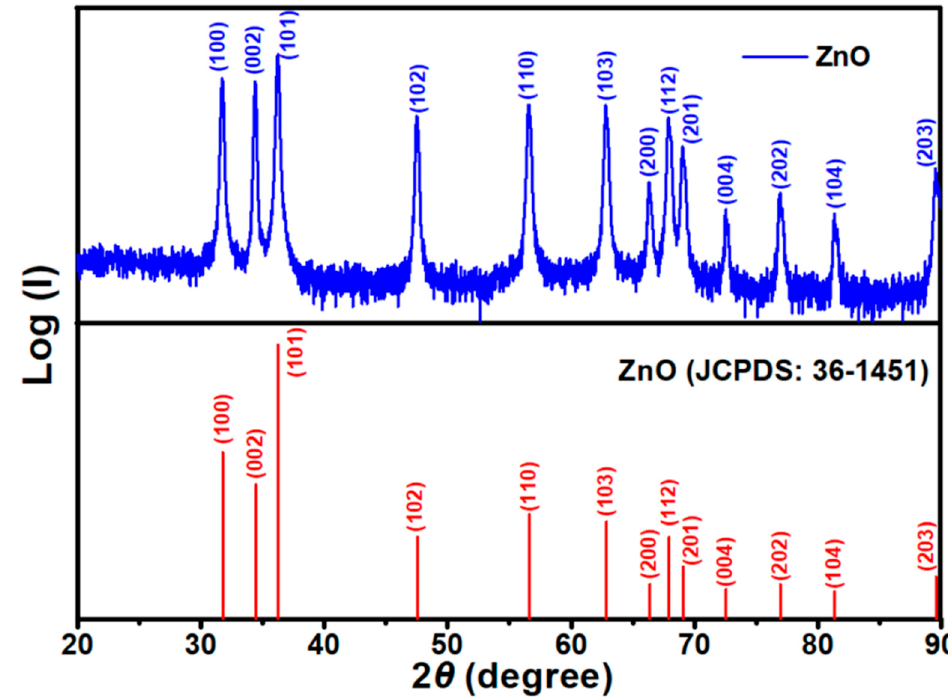
Figure 1. XRD pattern of the as-prepared lettuce-like ZnO.